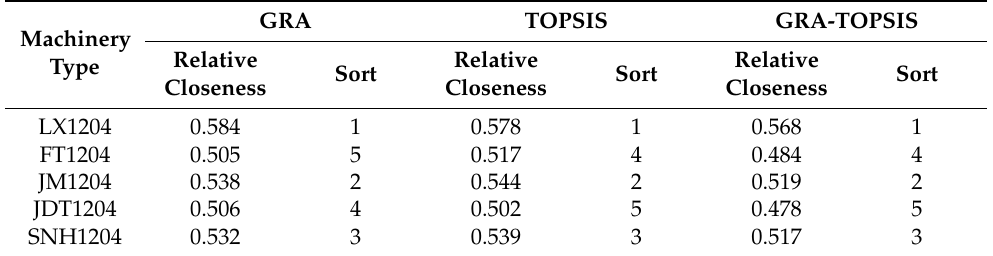
Table 6. Comparison of relative closeness and ranking of three methods ( β 1 = 0.5, β 2 = 0.5